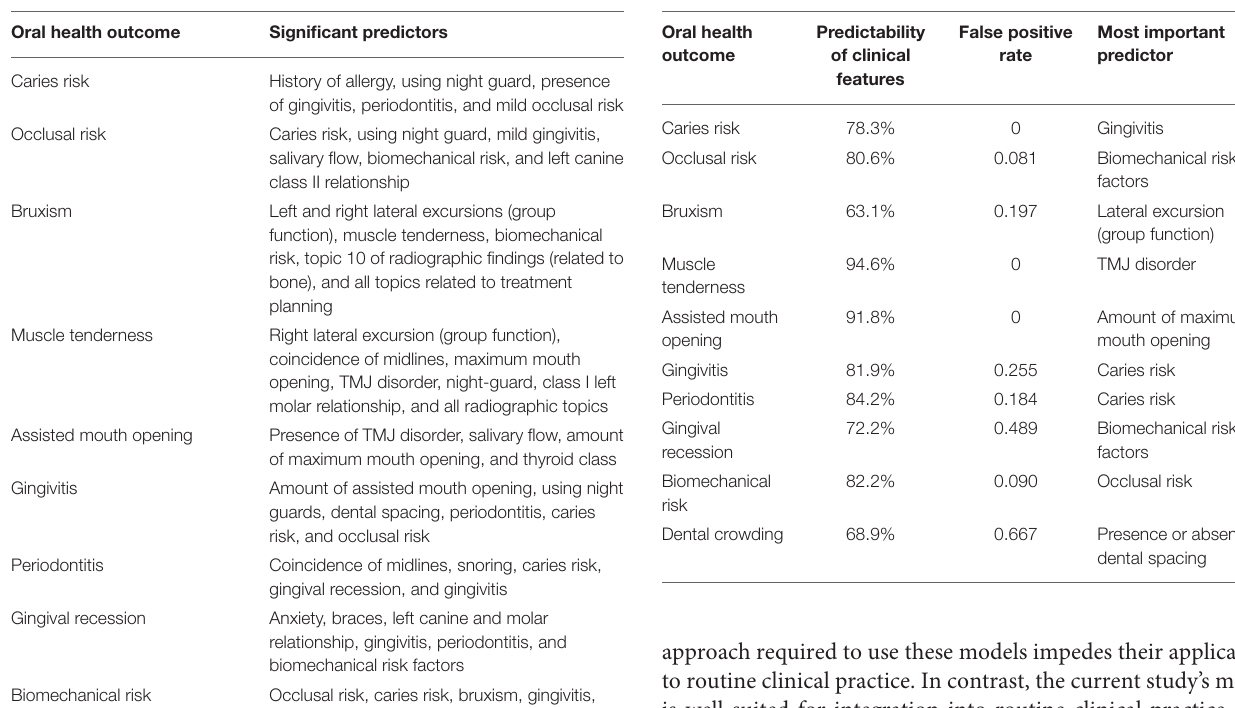
TABLE 3 | Predictability of various clinical features and topics for oral health outcome and the most important